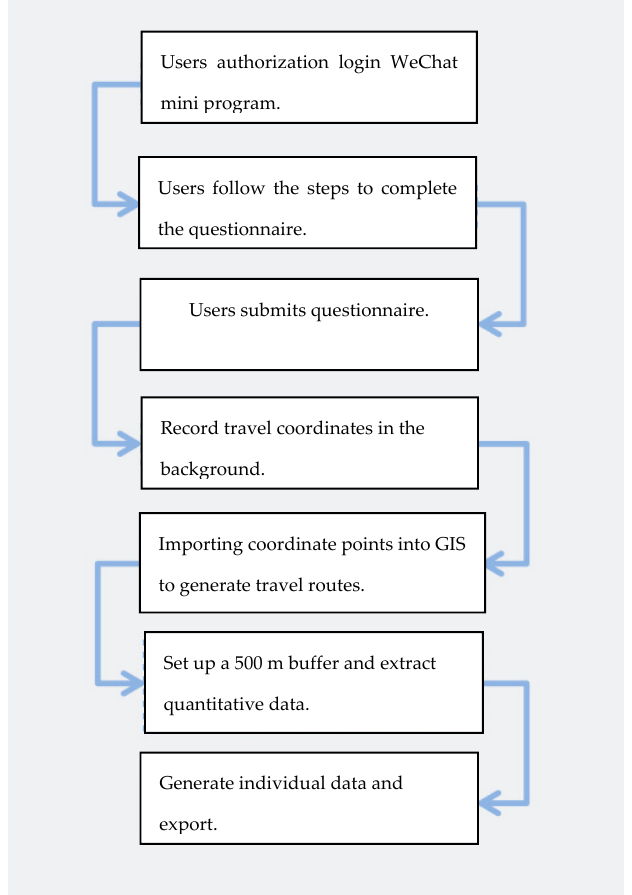
Figure 2. WeChat mini program collects the steps of urban built environment.